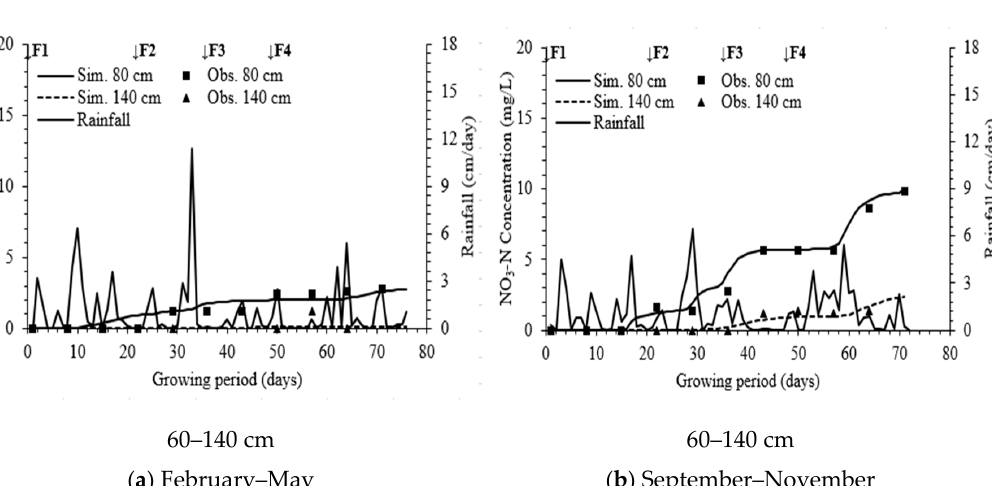
Figure 6. Comparison of simulated (Sim.) and observed (Obs.) NO 3 − -N concentrations during the ( a ) first season and ( b ) second season.